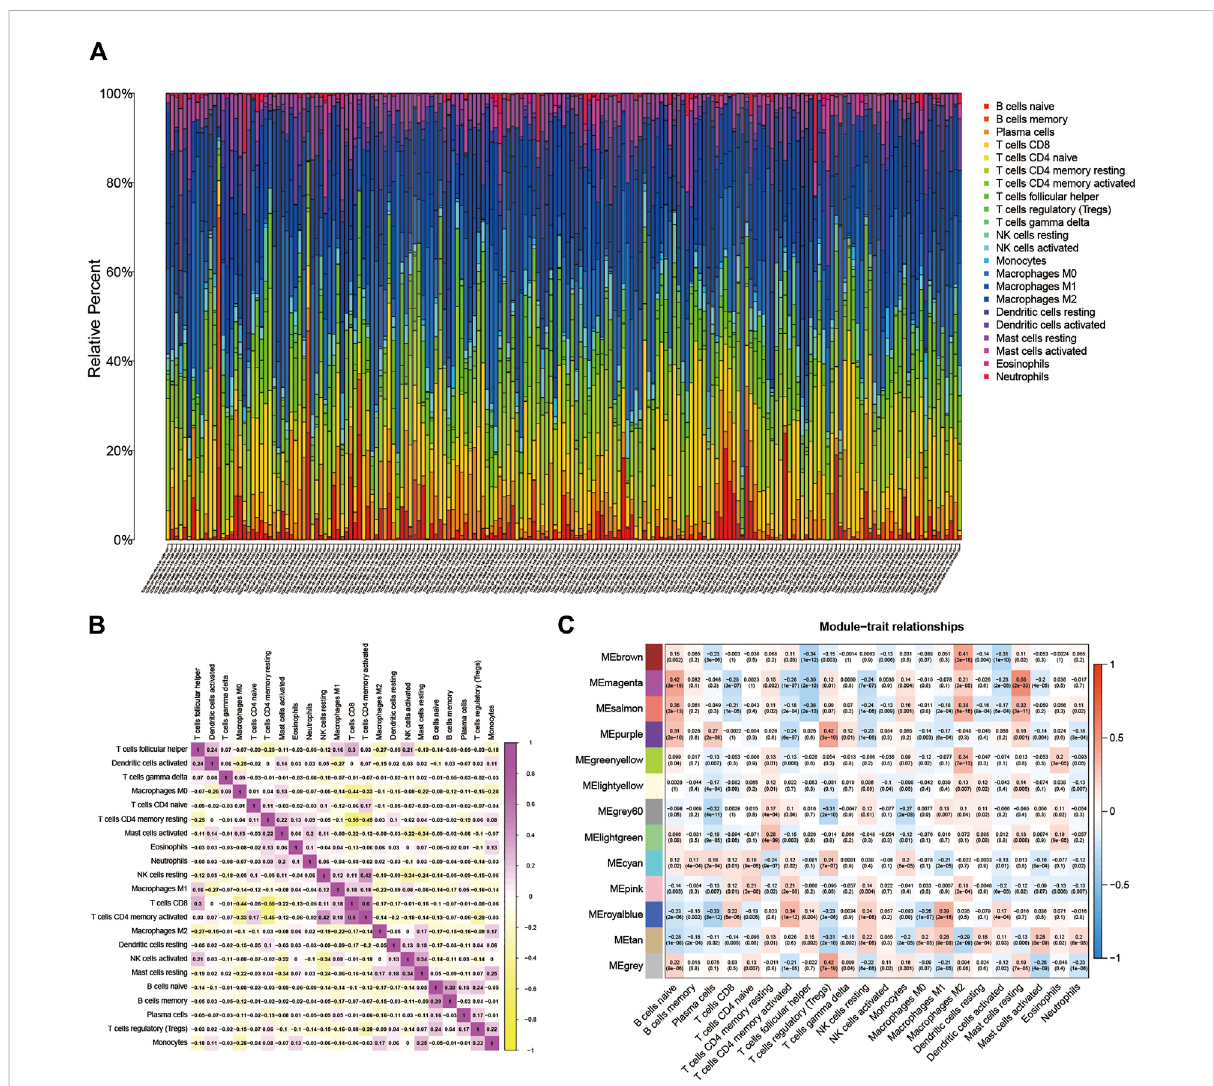
FIGURE 1 (A) Subpopulationof22immunecells. (B) Theintrinsiccorrelationbetween22immunecells. (C) Heatmapofcorrelationbetweenmodulesand TICs. Within every square, the number on the top refers to the coef fi cient between the cell in fi ltrating level and the corresponding module, and the bottom is the p